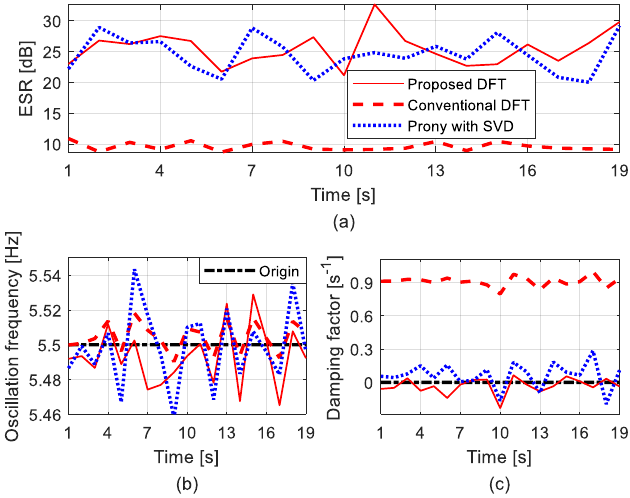
Figure 5. Estimated modal parameters in the simulation with a 10 dB SNR: ( a ) oscillation frequency of the first mode; ( b ) damping factor of the first mode; ( c ) oscillation frequency of the second mode; ( d ) damping factor of the second mode.